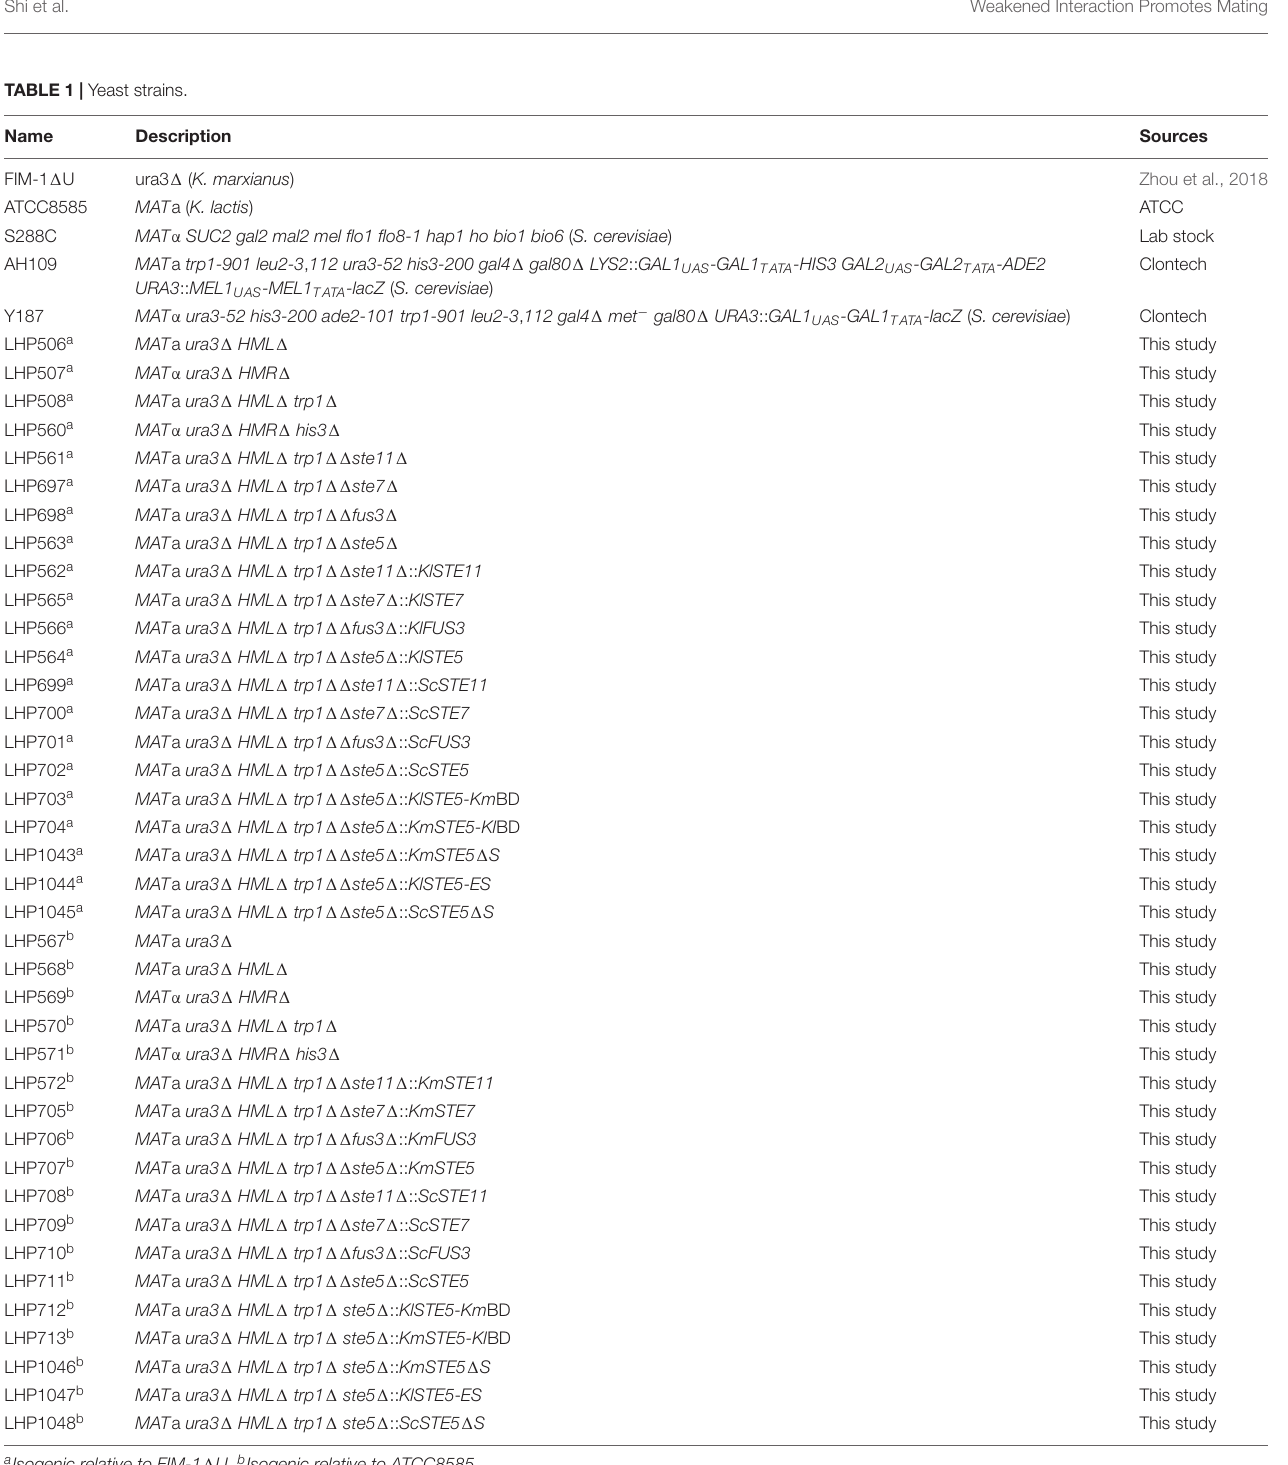
plasmids were constructed. Sequences encoding KmSTE5 , KlSTE5 , ScSTE5 , KlSTE5-KmBD , KmSTE5 - KlBD , KmSTE5 (cid:49) S , KlSTE5-ES, and ScSTE5 (cid:49) S was amplified and cloned into Eco RI site of pGADT7 (Clontech, 630442) by Gibson assembly. ORFs of Ste7 orthologs were amplified and cloned into Eco RI site of pGBKT7 (Clontech, 630448) separately by Gibson